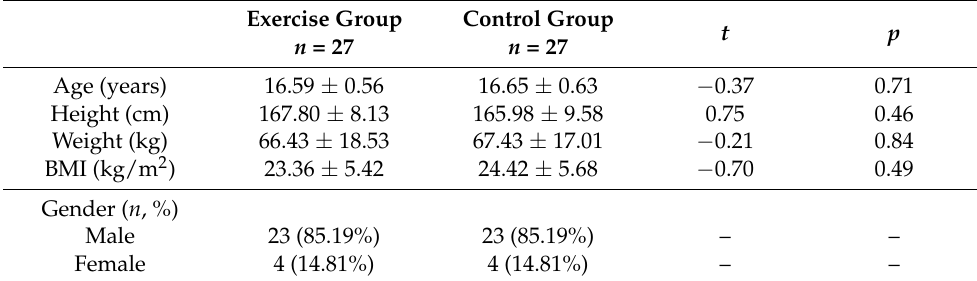
Table 1. Descriptive characteristics of the